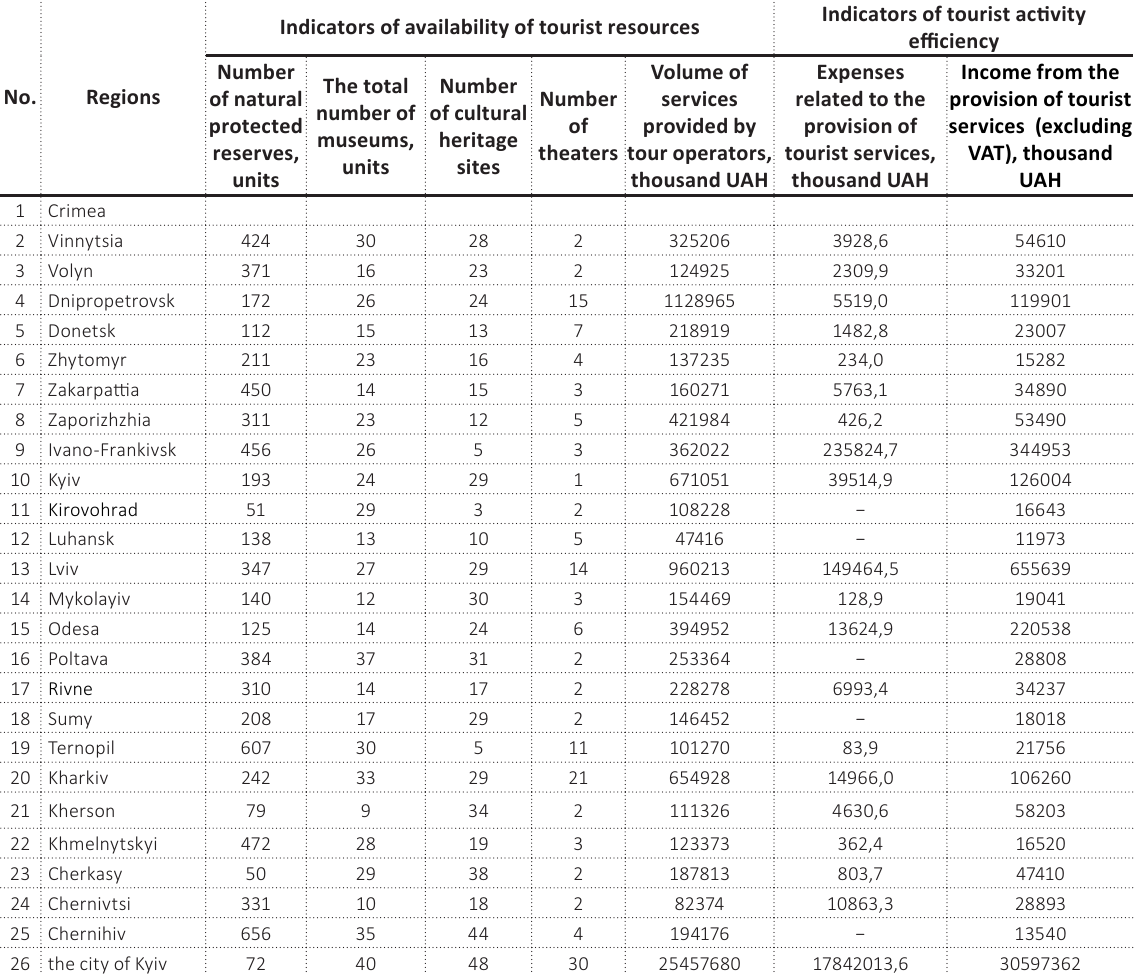
Table F1. Indicators of the availability of tourist resources and the efficiency of tourist activities in Ukraine’s regions in